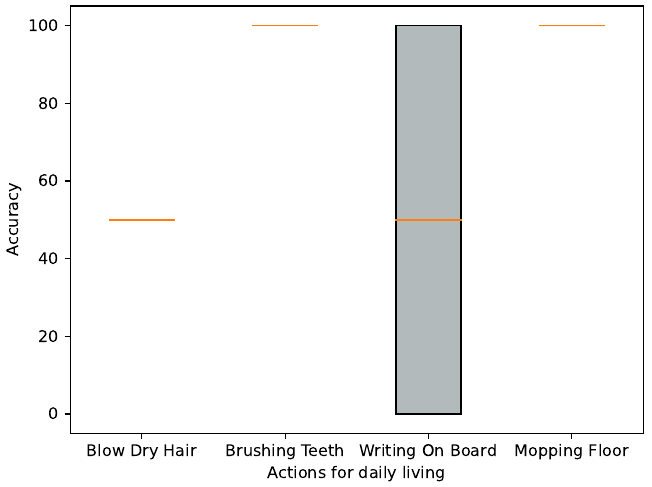
Figure 10. Results for patient UAH-2 based on LOLA’s actions monitoring